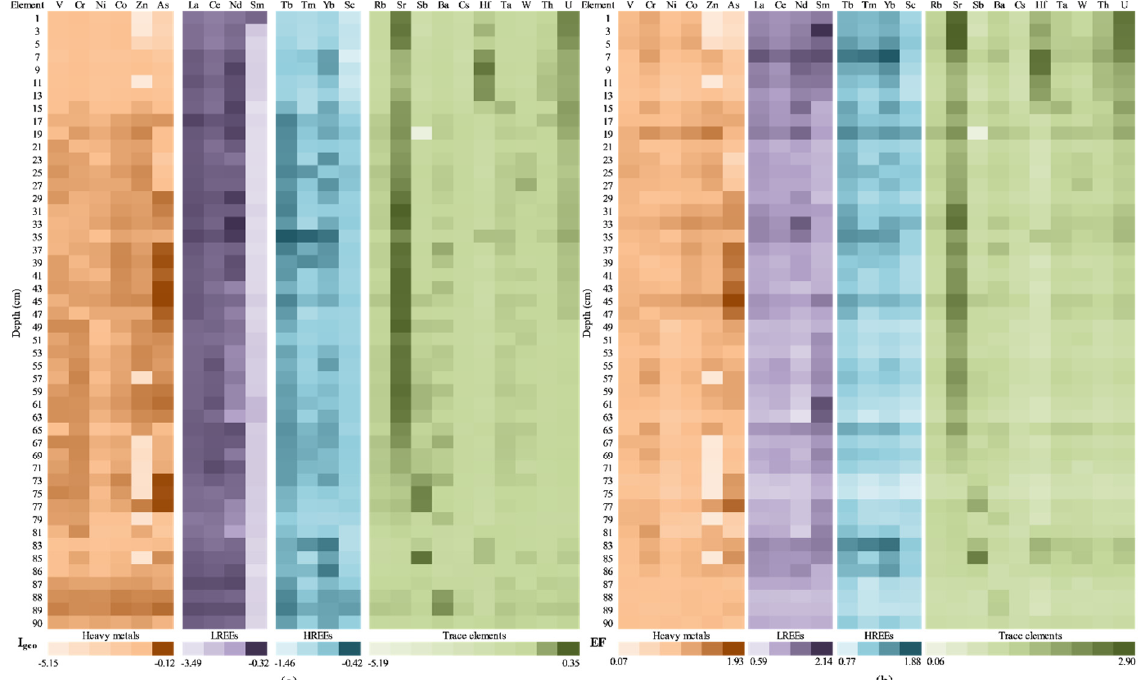
Figure 19. Geoaccumulation indices (I geo,s ) ( a ) and enrichment factors (EFs) ( b ) calculated from the Movila Miresii Lake sediment core (90 cm depth).